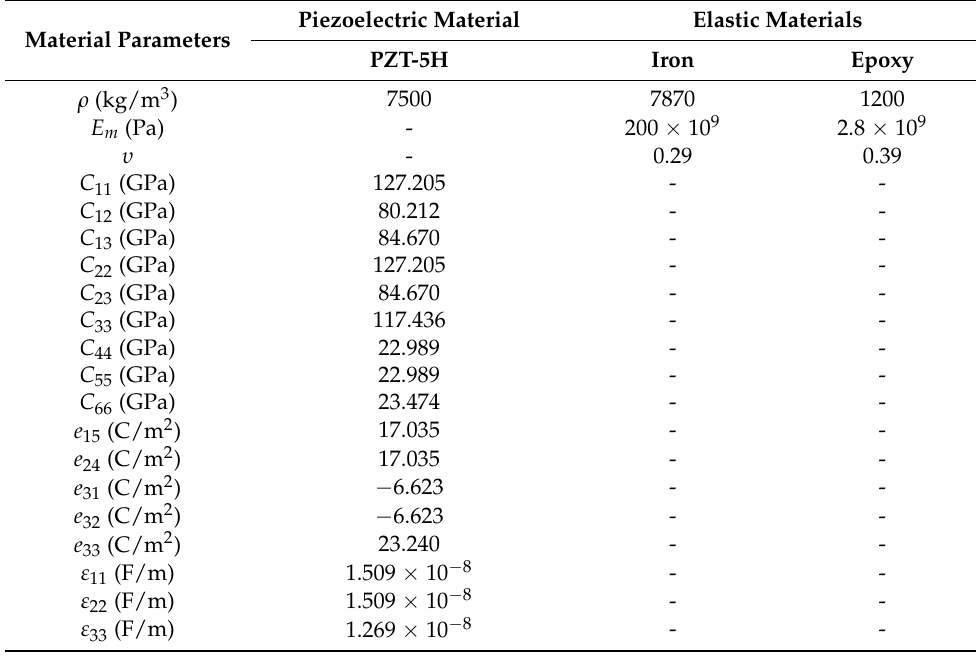
Table 1. Material constants of the elastic and piezoelectric components.